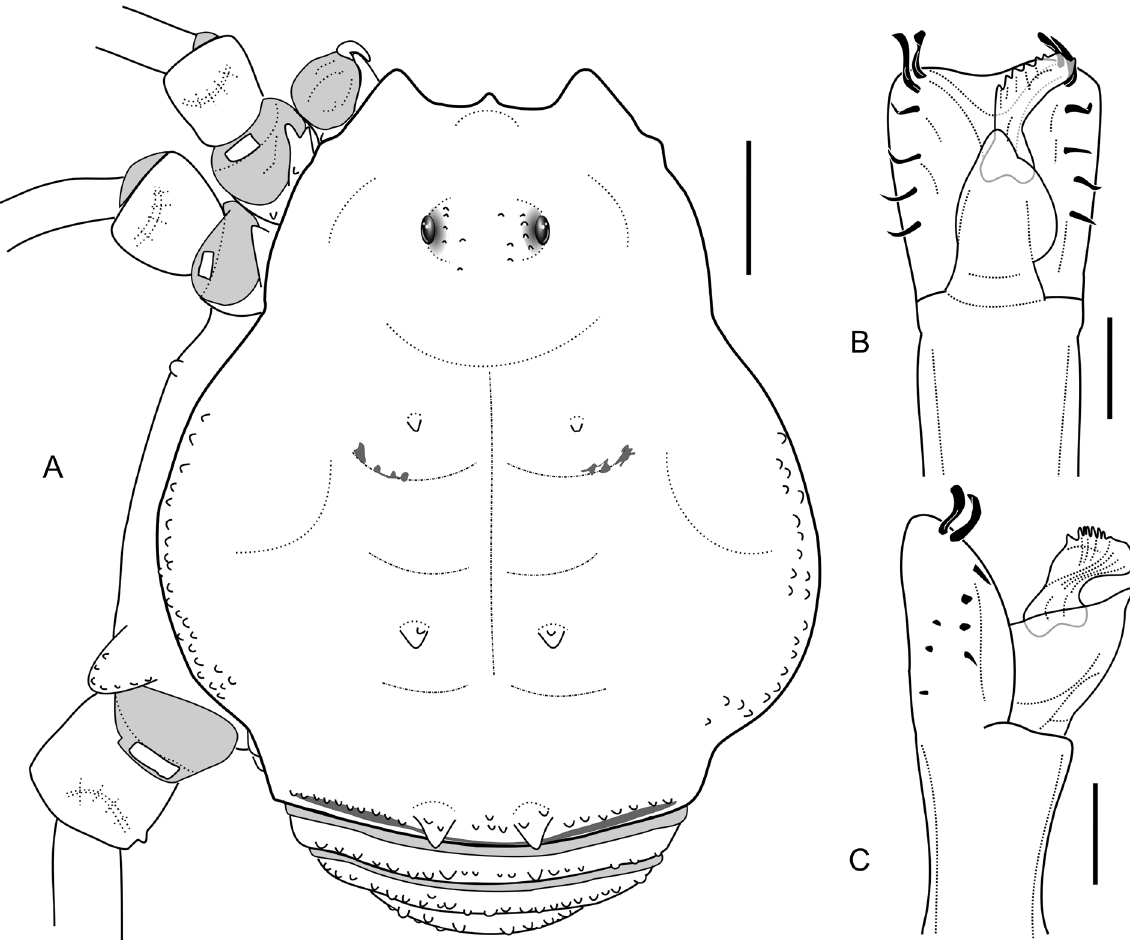
Fig. 6. Eulibitia castor sp. nov., ♂, holotype (ICN-AO 79). A . Habitus, dorsal view. B – C . Apical portion of the penis: B . Dorsal view. C . Lateral view. Scale bars: A = 1 mm; B–C = 0.1